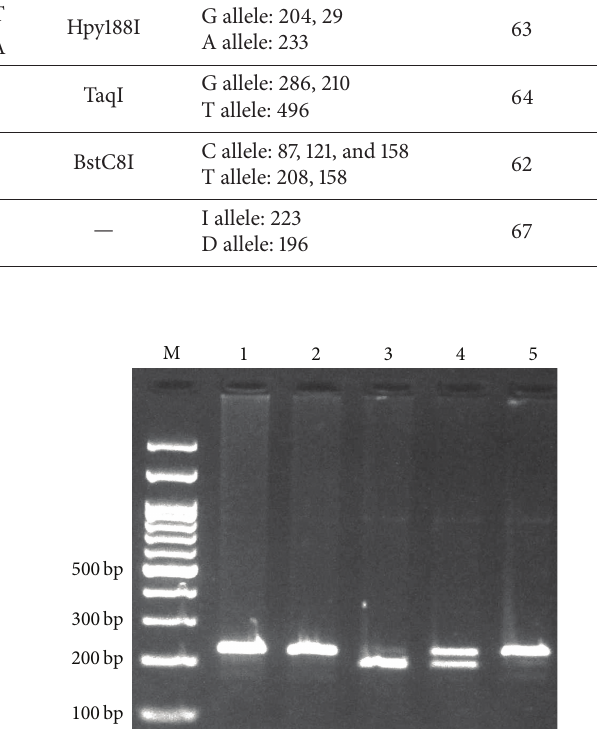
Figure 1: Electrophoresis pattern of polymerase chain reaction restriction fragments length polymorphism (PCR-RFLP) for detec- tion of IFNGR1 rs1327474 polymorphism. G allele digested by Hpy188I restriction enzyme and produces 204 and 29bp while A allele undigested (233 bp). M: DNA marker; lanes 1, 2, and 5: AA; lane 3: GG; lane 4: